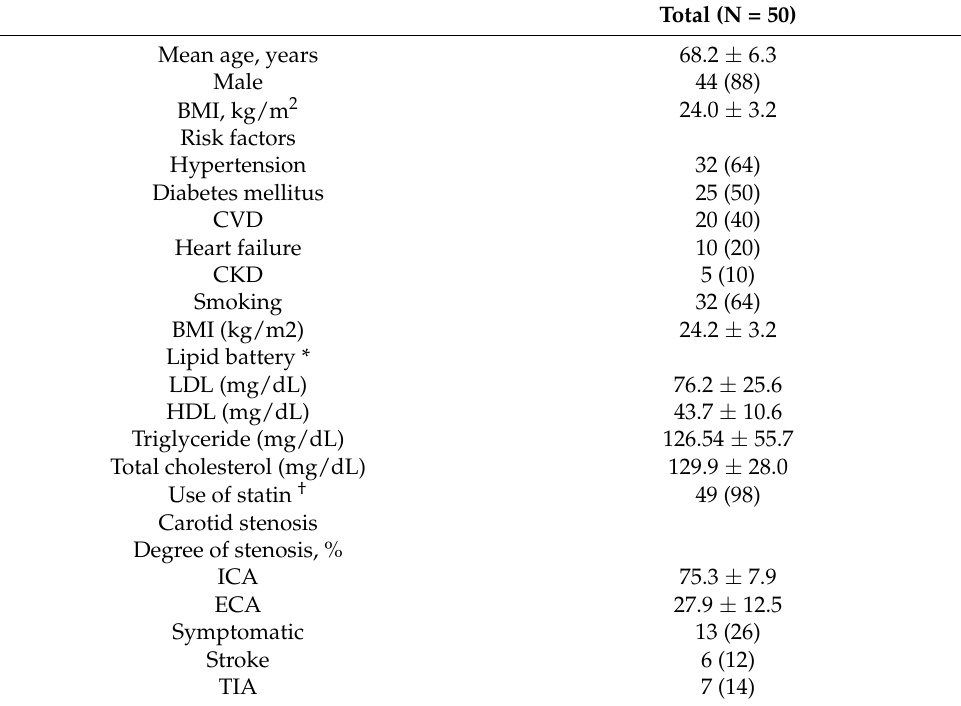
Table 1. Baseline demographic and clinical characteristics of the study population.